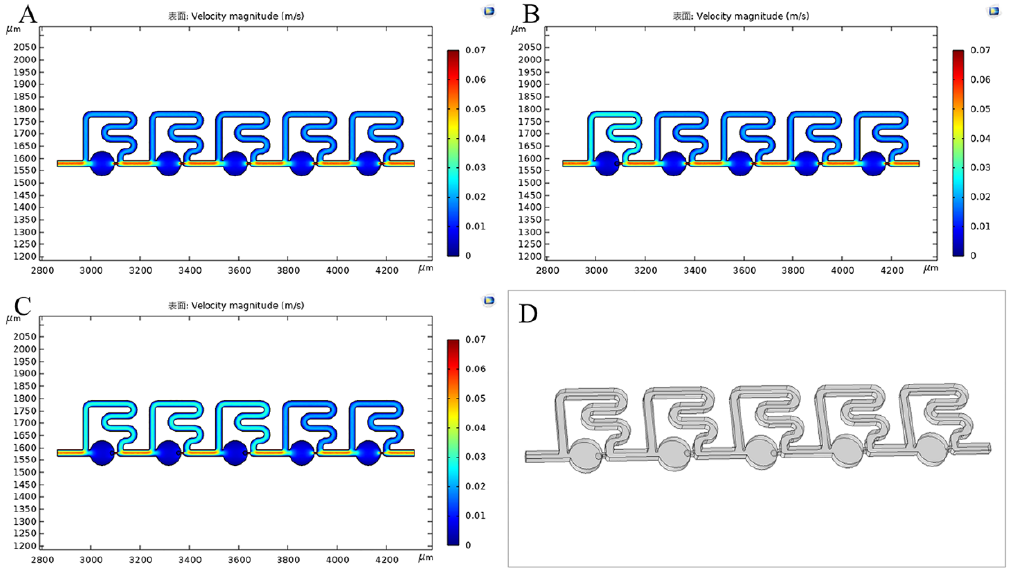
Table 1. Q ratio values of the five sites of the optimized model when zero, one, two and three cells were trapped, respectively.